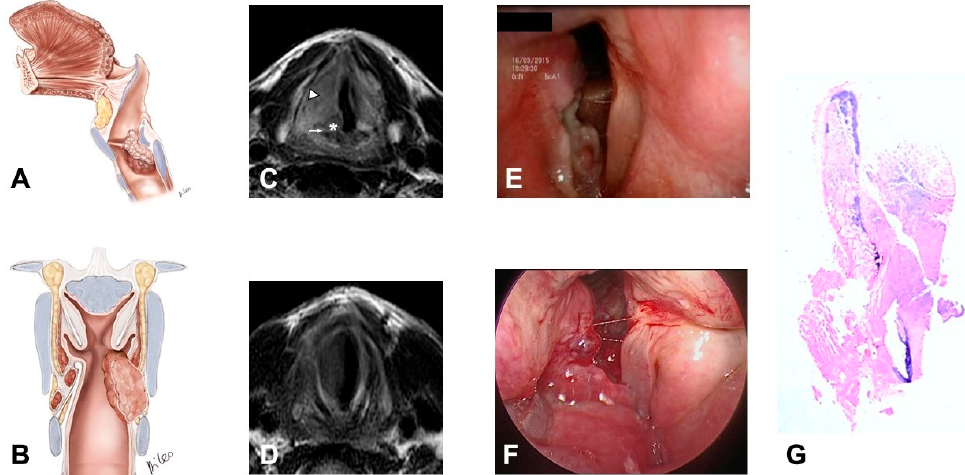
inner cortex of the thyroid cartilage reaching the inferior aspect of the latter.